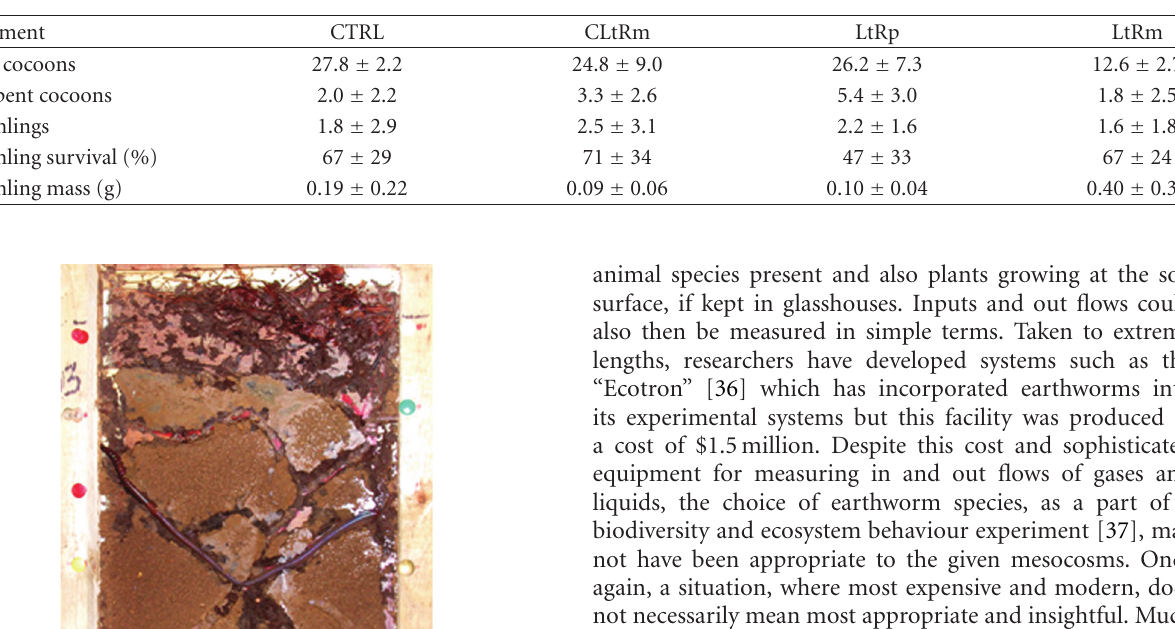
Table 2: Details of cocoons and hatchlings of Lumbricus terrestris (mean ± SD) produced under a number of adult manipulations in Evans’ boxes, kept at 17 ◦ C in darkness (CTRL: no manipulation; CLtRm: earthworm removed and reintroduced; LtRp: earthworm removed and replaced by another; LtRm: earthworm removed—adapted from [34]).